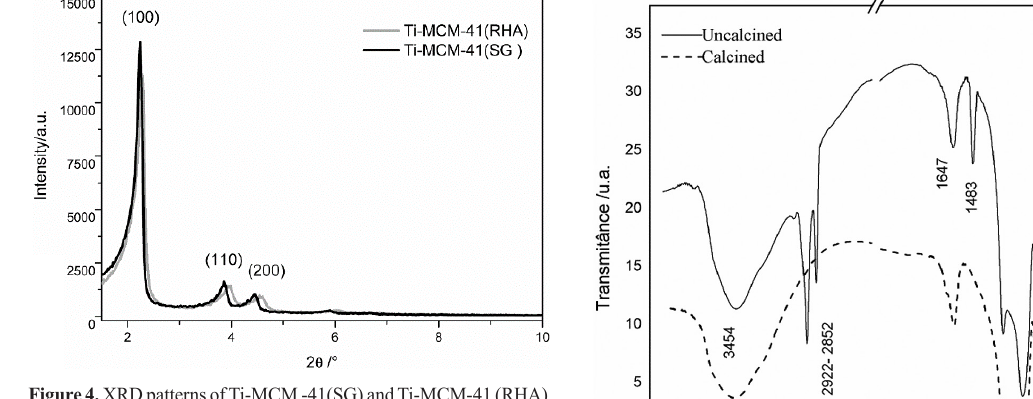
Figure 4. XRD patterns of Ti-MCM -41(SG) and Ti-MCM-41 (RHA).